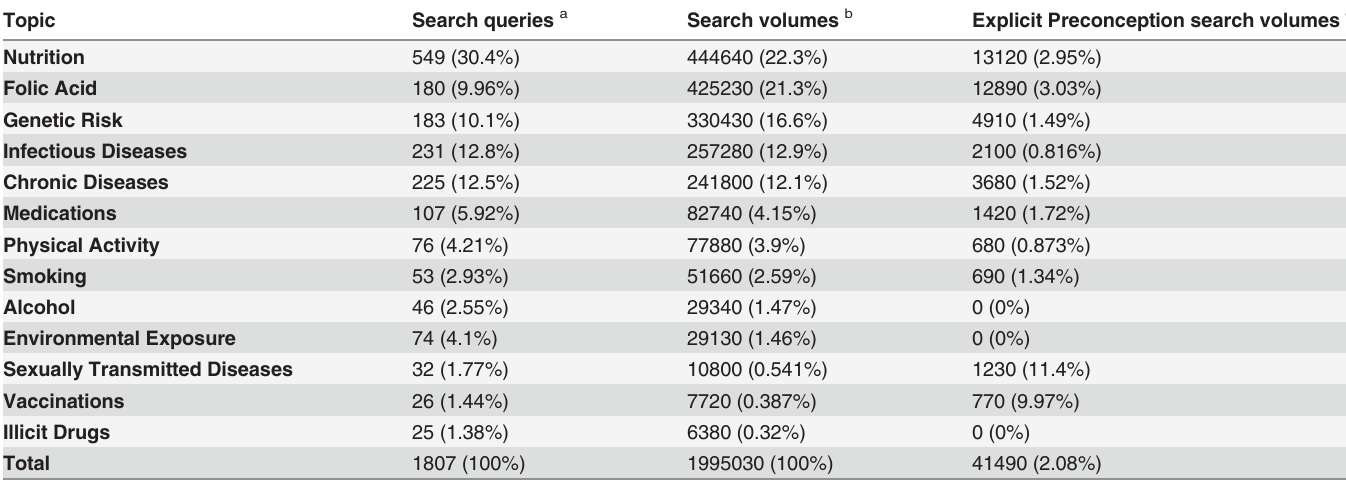
Table 1. Google search data by topic and their corresponding